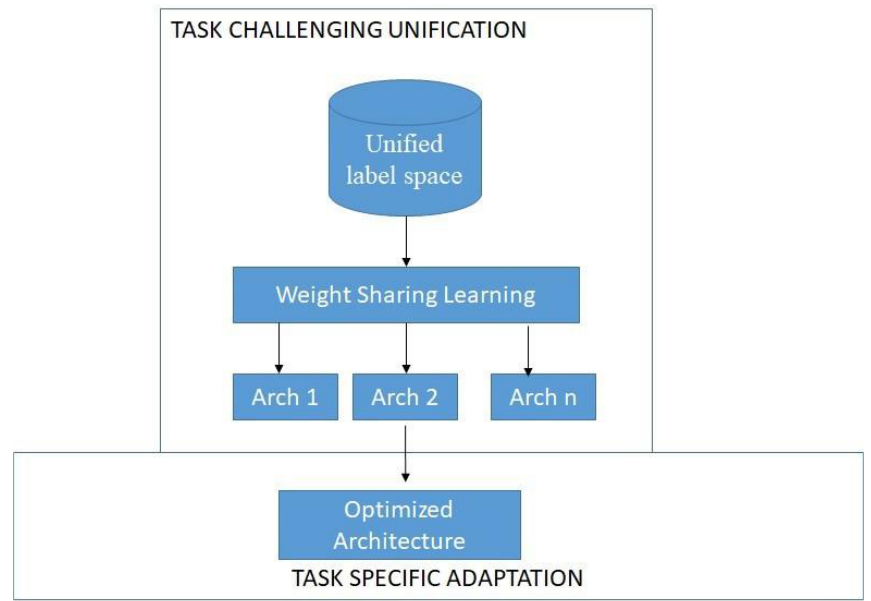
Figure 2. Proposed transfer learning